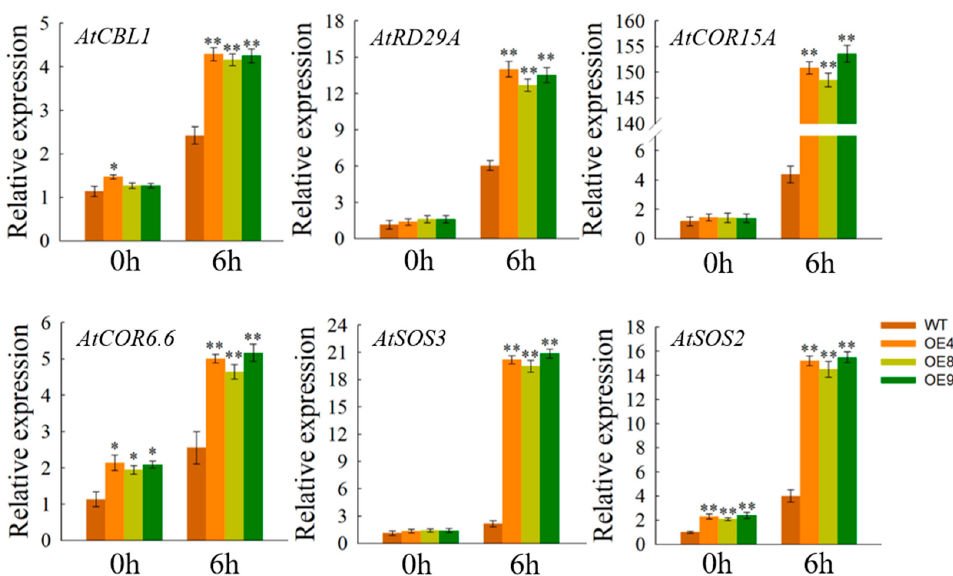
Figure 8. Expression of abiotic stress response genes in OfSPL11 -overexpressed lines and WT Ara- bidopsis . Each experiment had three biological replicates. * p < 0.05 and ** p < 0.01 were used to de- termine statistical significance.